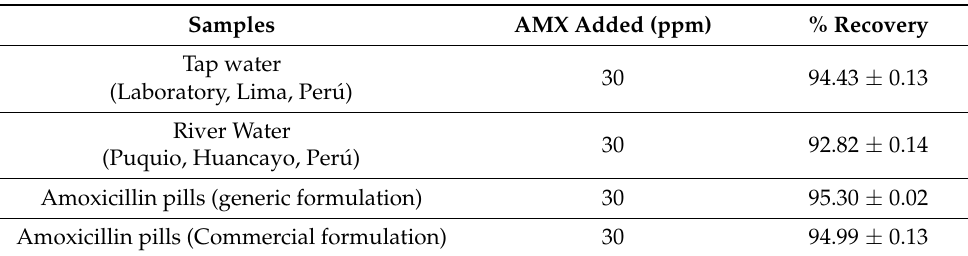
Table 6. % Recovery from superparamagnetic Imprinted polymer (SP-MIP) in the analysis of regional river and tap water and two types of amoxicillin pills. Standard deviation for n = 3.